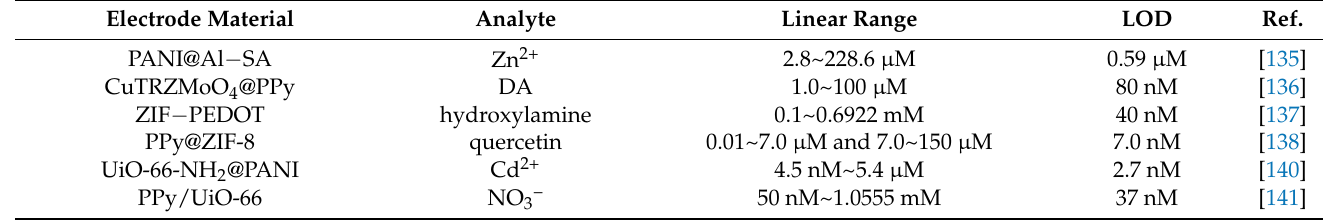
Table 4. Detection performances of different conductive polymer and modified MOF − based electro- chemical